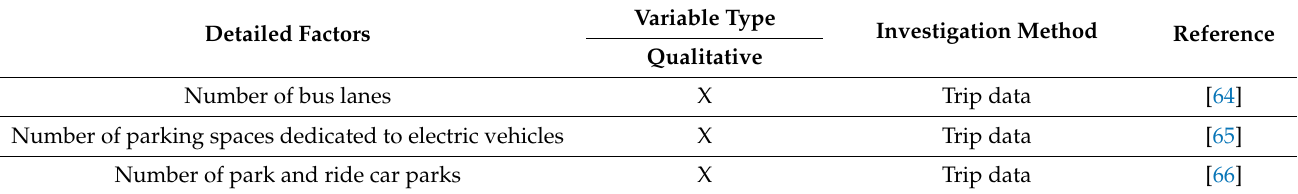
Table 7. Factors related to infrastructure.